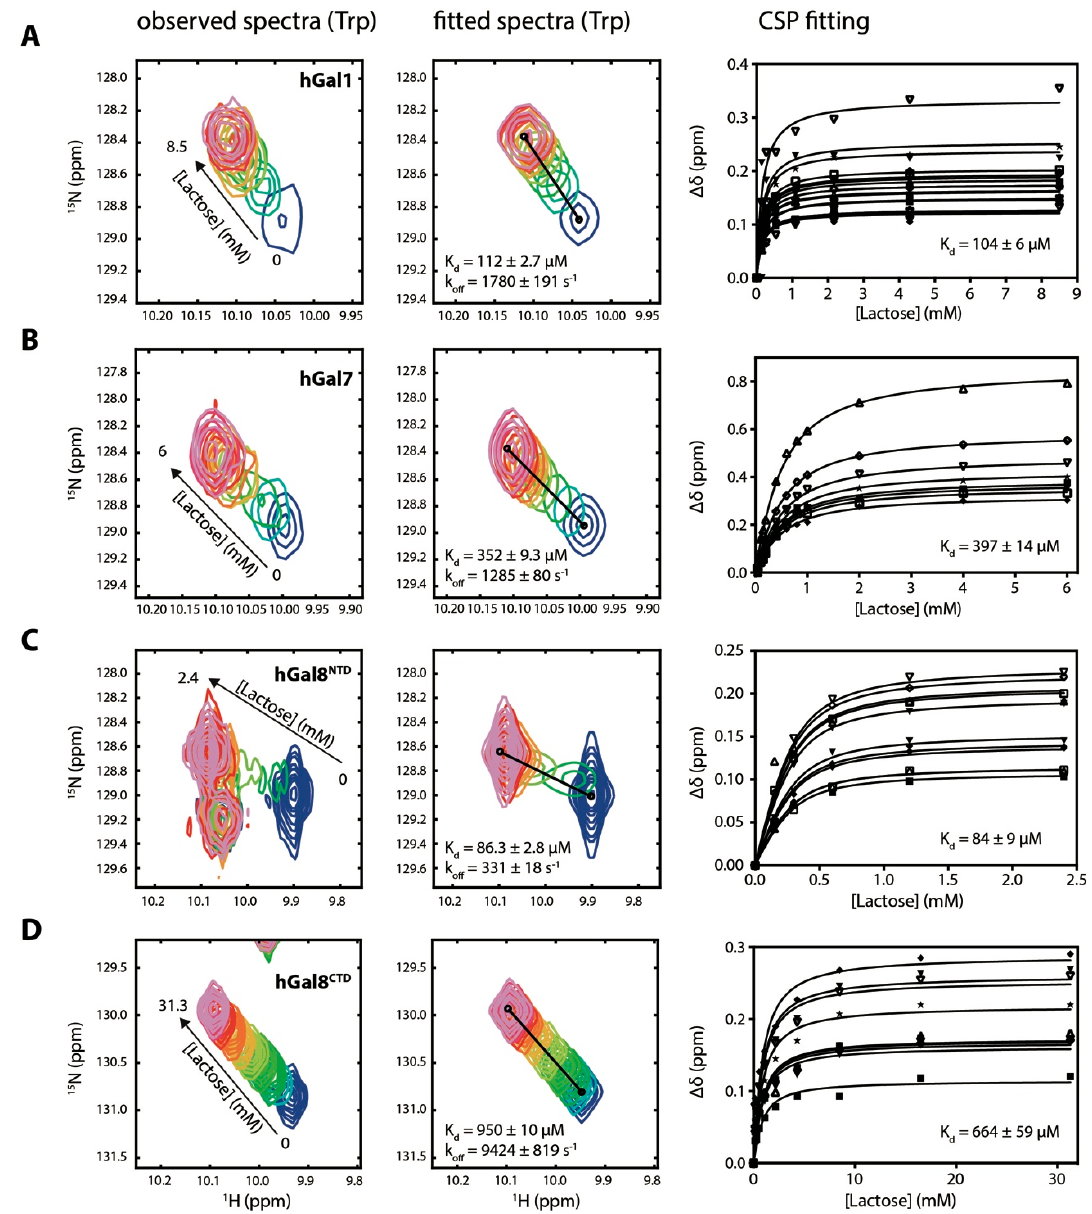
Figure 2. Lactose titration of galectins monitored by NMR spectroscopy. Observed and fitted 15 N- 1 H band-selective optimised-flip-angle short-transient heteronuclear single-quantum correlation (SOFAST-HMQC) spectra corresponding to the tryptophan indole resonances of ( A ) hGal1, ( B ) hGal7, ( C ) hGal8 NTD , and ( D ) hGal8 CTD are shown in the left and middle panels. The cross peaks are colour-ramped from blue to pink with increasing lactose concentration, as indicated by the titration points shown on the right panels with different final lactose concentrations as indicated by the arrows on the left panels. Details of the titration points are defined in Figure S1. Fitting results from TITAN program are indicated. Global fitting of the CSPs as a function of lactose concentration and the resulting K d values for corresponding galectins are shown in the right panels. The titrations curves correspond to the residues that exhibit significant CSPs as defined in Figure 4, without severe overlaps throughout the titration to enable the calculations of individual CSPs at each titration point .